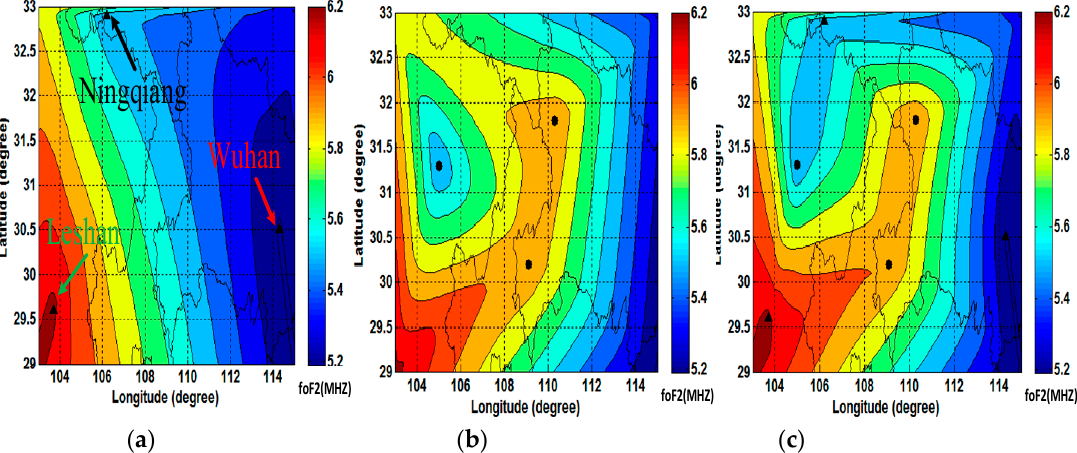
Figure 9. foF2 maps: ( a ) is the map reconstructed according to the data of only three vertical-incidence soundings, ( b ) is based on the three oblique-incidence soundings’ data, and ( c ) is the map involving the vertical-incidence soundings and the oblique-incidence soundings.